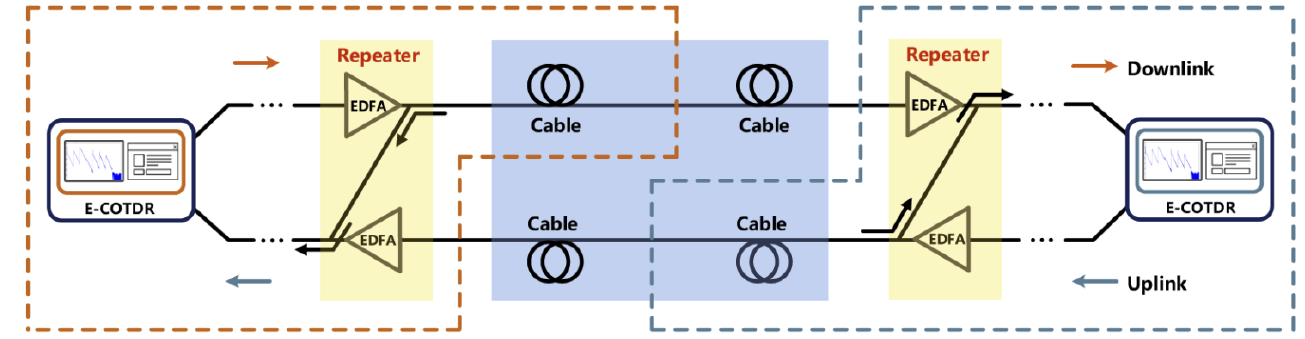
Figure 26. Schematic diagram of submarine cable link [88].